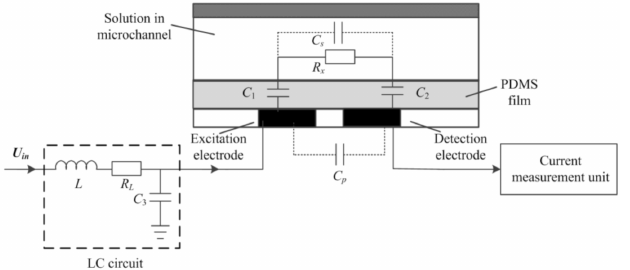
Figure 3. The construction of the new C 4 D sensor.